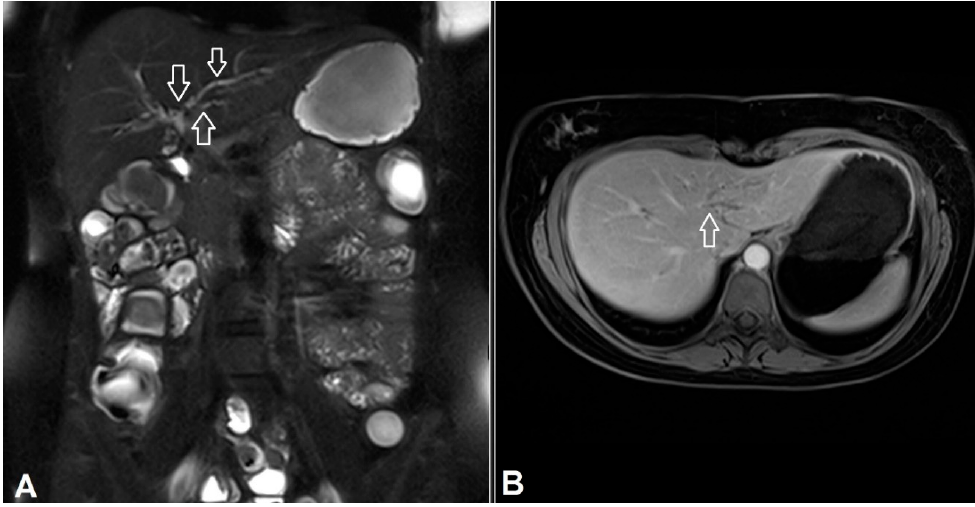
Figure 4. Primary sclerosing cholangitis in a 25-year-old female patient. The intrahepatic bile ducts were irregularly configured with multiple strictures (white arrows in A) and dilatation (white arrow in B). ( A ) Fat-saturated T2w HASTE. ( B ) T1w-3D-VIBE with contrast agent and fat saturation.